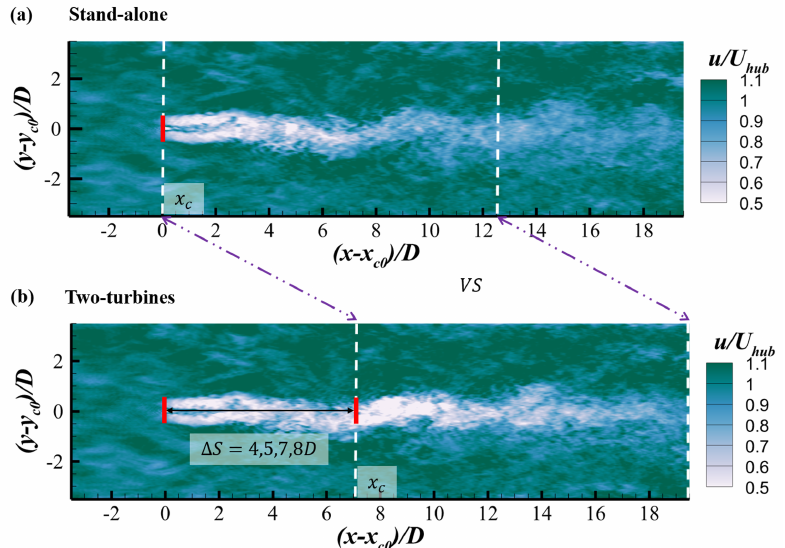
Figure 4. Contours of instantaneous streamwise velocity on the horizontal plane located at turbine hub height for ( a ) the stand-alone turbine case and ( b ) the two-turbine case with ∆ S / D = 4 for inflow1 with k 0 = 0.001 m.